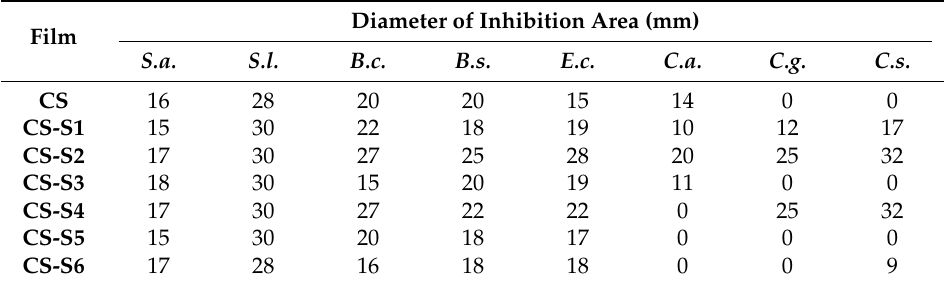
Table 1. Diameter of inhibition area (mm) of chitosan film (CS) and chitosan-derivative films. Film